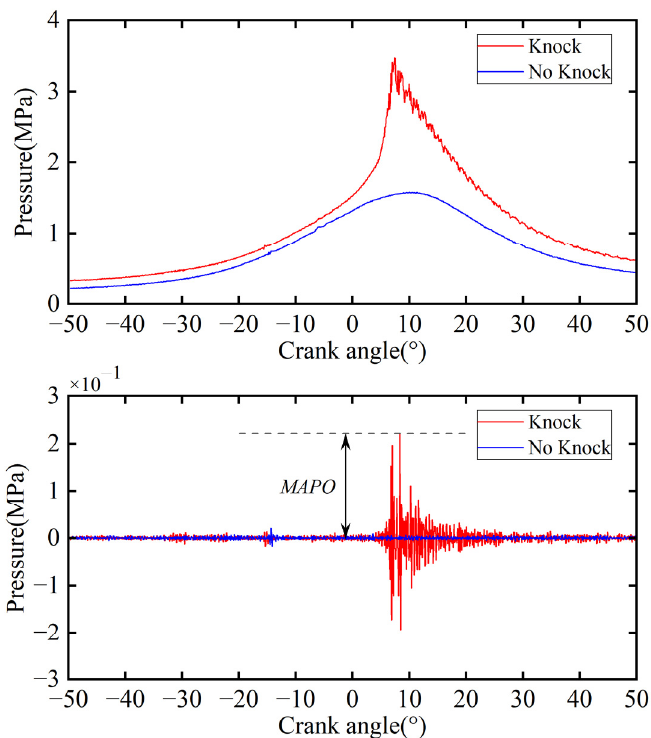
Figure 2. In-cylinder combustion pressure signal and filtered signal for knock detection.